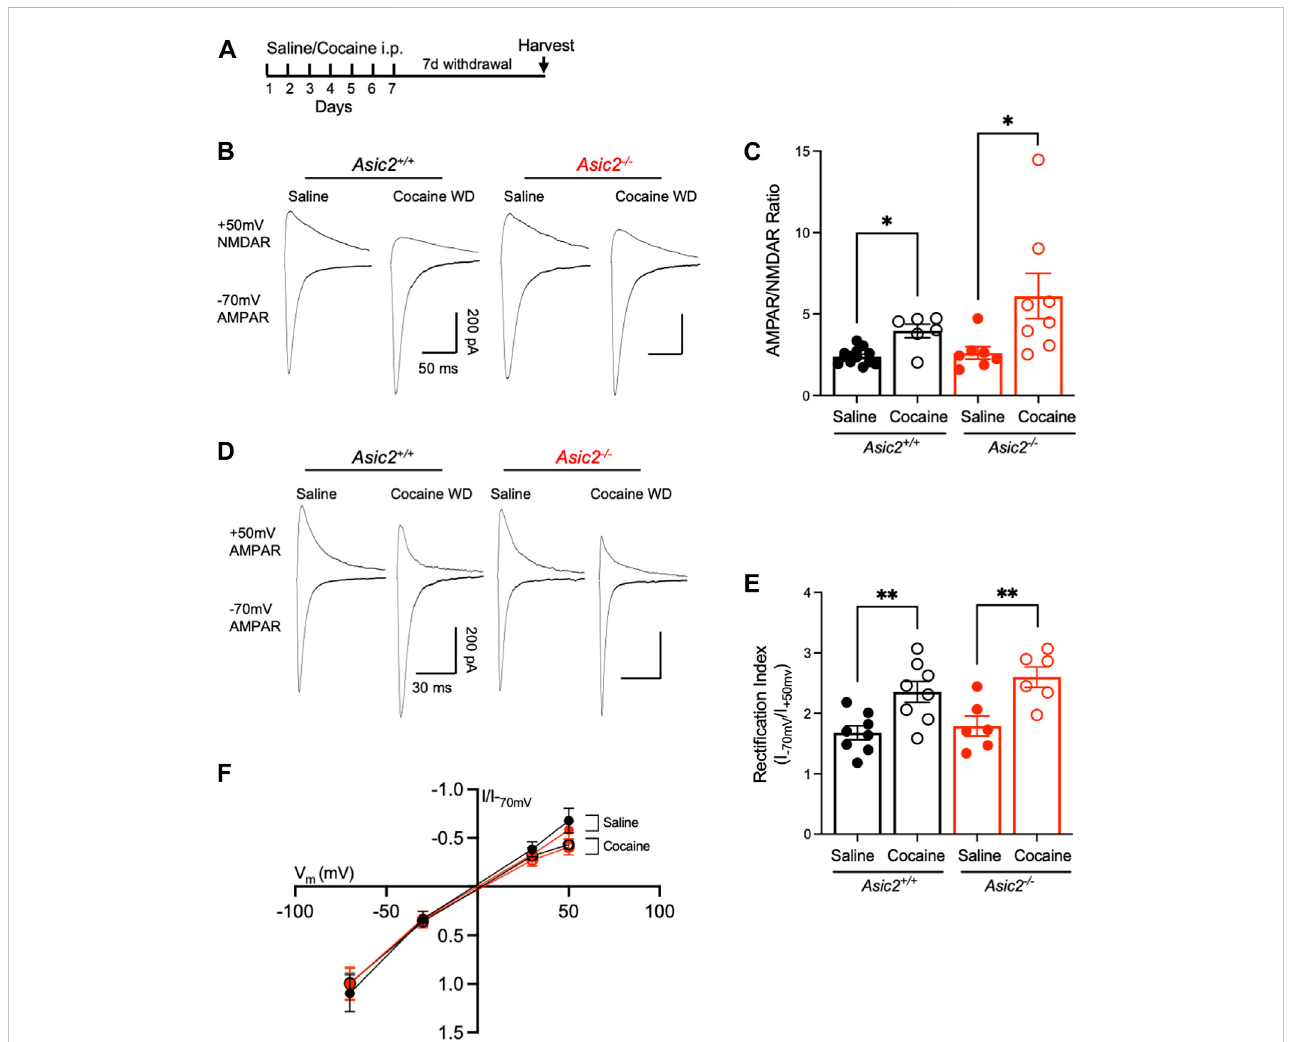
FIGURE 4 Disrupting ASIC2 subunits did not alter AMPAR/NMDAR ratio or recti fi cation index in NAcc in acute slices at baseline or after cocaine withdrawal. (A) Timeline of saline or cocaine home cage injections followed by withdrawal. (B) Representative traces of AMPA receptor-mediated EPSC at − 70 mV holding potential andNMDAreceptor-mediated EPSCat+50 mVholdingpotential ofdesignatedgroups. (C) Anordinarytwo-way ANOVAassessingAMPAR/NMDAR ratio revealed a signi fi cant effect of cocaine withdrawal but no effect of disrupting ASIC2 and no interaction between genotype and drug exposure [F (1,30) = 12.30, p = 0.0014 drug effect; F (1,30) = 2.661, p = 0.1133 genotype effect; F (1,30) = 1.786, p = 0.1915 interaction, n = 6 – 13 cells]. T-tests revealed an effect of cocaine withdrawal in wild-type [t (5.983) = 3.577, p = 0.0117, Welch ’ s t -test, n = 13 and 6 cells] and Asic2 − / − mice [t (8.060) = 2.425, p = 0.0413, Welch ’ s t -test, n = 7 and 8 cells]. A t -test revealed no effect of ASIC2 disruption in cocaine withdrawn groups [t (8.232) = 1.476, p = 0.1771, Welch ’ s t -test, n = 6 and 8 cells]. (D) Representative traces of AMPA receptor-mediated EPSC at − 70 and +50 mV holding potential for designated groups. (E) An ordinary two- way ANOVA assessing the ratio of AMPA receptor-mediated current at − 70 mV to +50 mV revealed a signi fi cant effect of cocaine withdrawal on inward recti fi cation but no effect of disrupting ASIC2 and no interaction between genotype and drug exposure [F (1,24) = 22.04, p = < 0.0001 drug effect; F (1,24) = 1.293, p =0.2667genotypeeffect;F(1,24)=0.1723, p =0.6818interaction, n =6-8cellseach].T-testsrevealedaneffectofcocainewithdrawalinwild-type (t (14) = 3.240, p = 0.0059, Student ’ s t -test, n = 8 cells each) and Asic2 − / − mice [t (10) = 3.422, p = 0.0065, Student ’ s t -test, n = 6 cells each) (F)